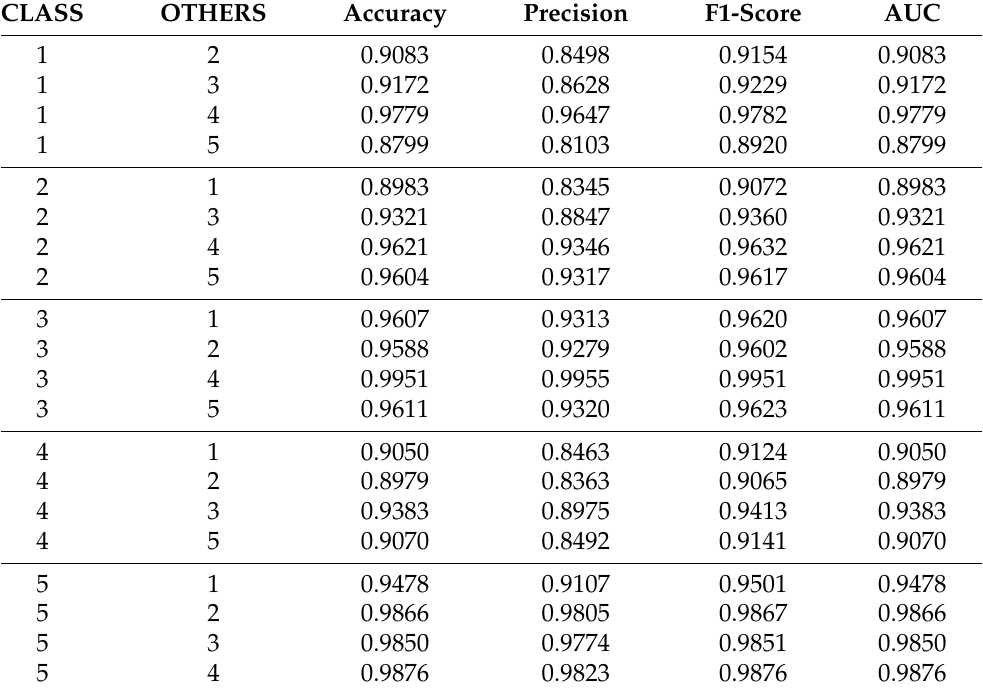
Table 2. DBN-driven LOF identification results.